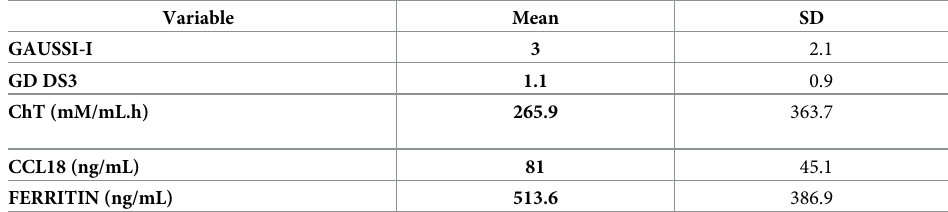
Table 2. Biological parameters and severity score index in patients with GD Type I.